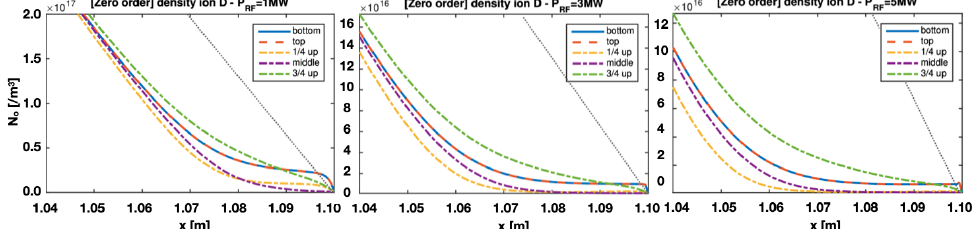
Figure 9. Zero-order density at five poloidal positions (bottom, 1/4 up, middle, 3/4 up, and top) for P RF = 0 ( left ), P RF = 3 MW ( middle ), and P RF = 5 MW ( right ). The grey dotted line is the density variation in absence of RF power according to the simplified model